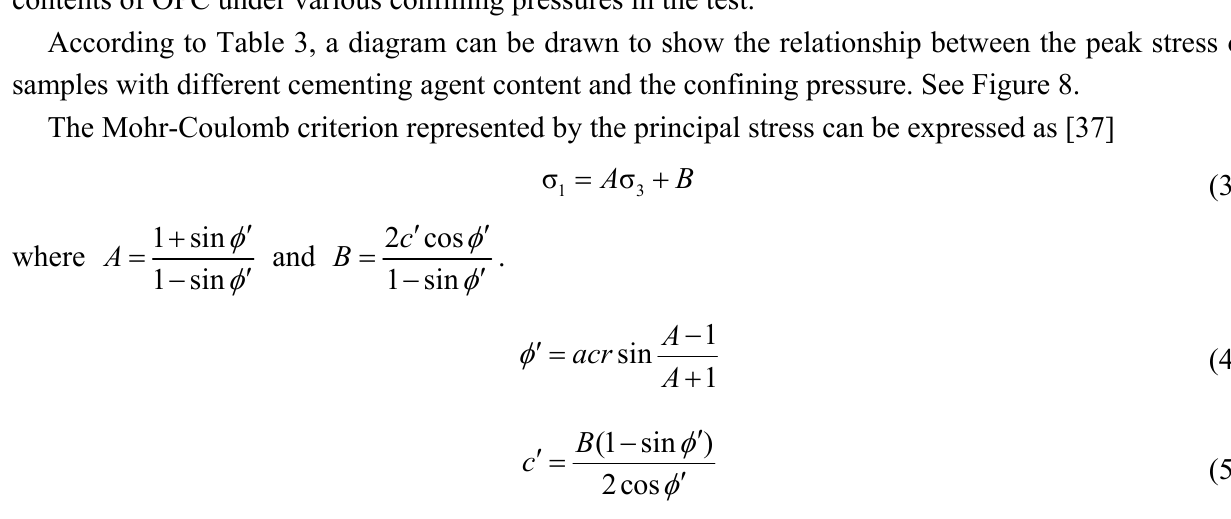
Table 3. The peak stress of samples under different